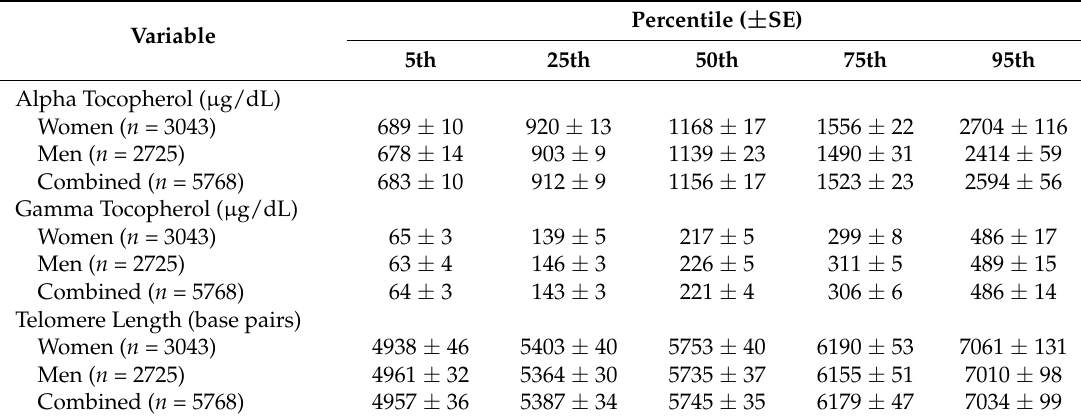
SE: standard error. Table values include person-level weighted adjustments based on the sampling design of NHANES so that values reflect those of the US adult